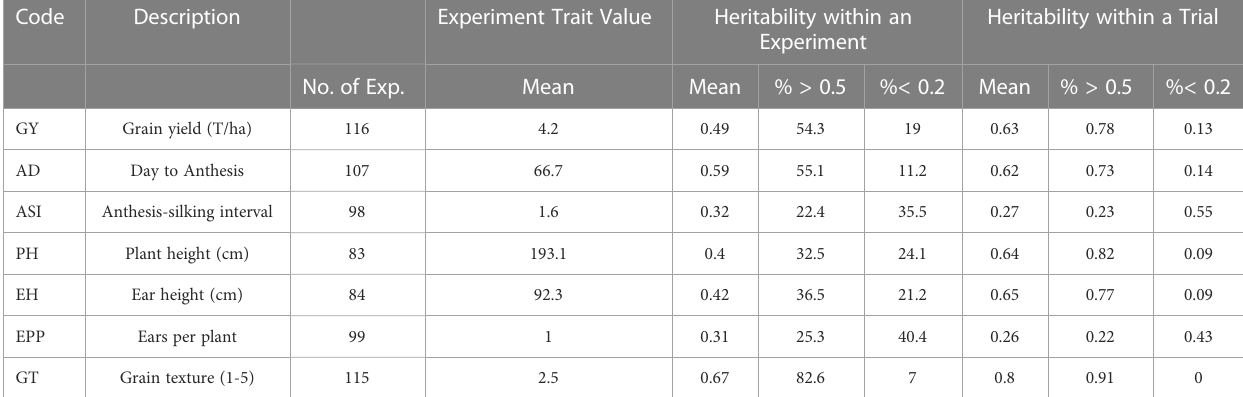
TABLE 4 List of traits assessed, and a summary of the average trait values and entry mean heritability within an experiment.